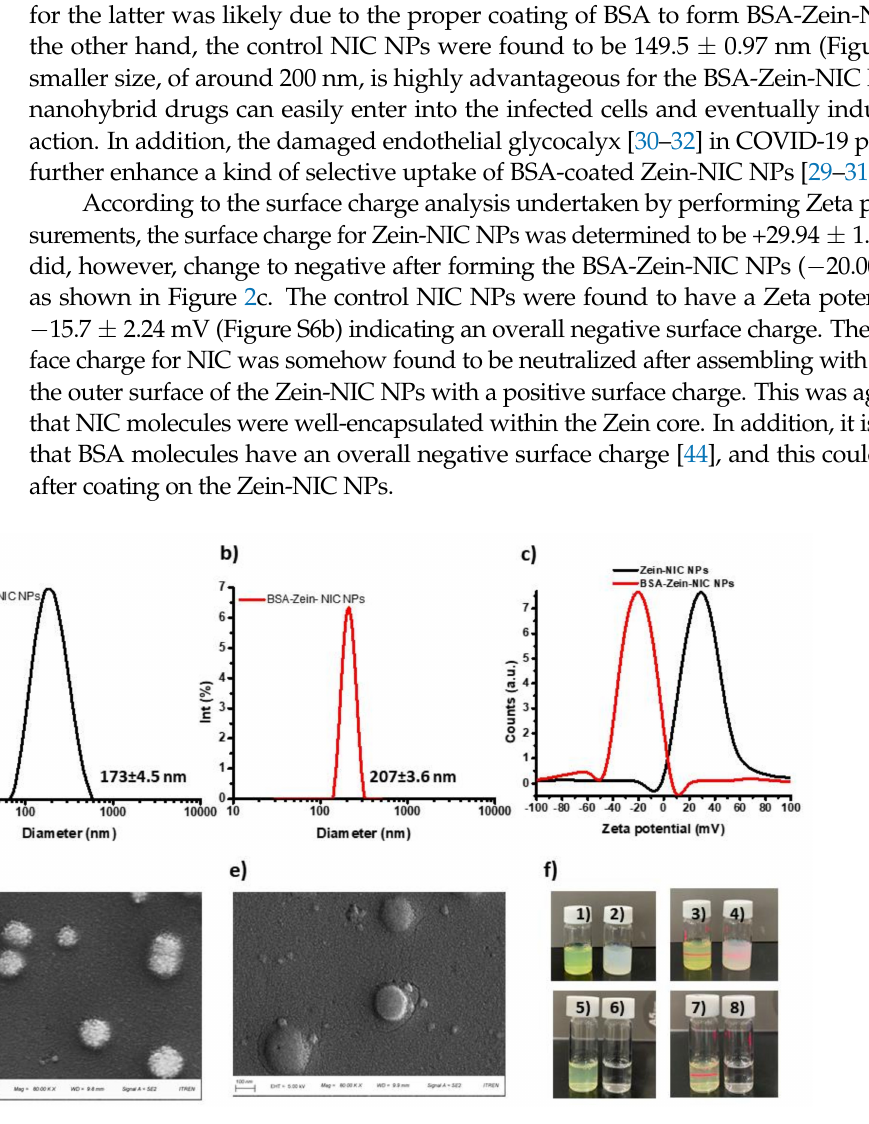
Figure 2. Particle size analysis by DLS and FE-SEM: ( a ) Zein-NIC NPs; ( b ) BSA-Zein-NIC NPs; ( c ) Zeta potential for Zein-NIC NPs and BSA-Zein-NIC NPs in water. FESEM analysis: ( d ) Zein-NIC NPs; ( e ) BSA-Zein-NIC NPs; ( f ) colloidal stability observed for Zein-NIC NPs (2,4,6, and 8) and BSA-Zein-NIC NPs (1,3,5, and 7) before the freeze-drying process (1–4) and after dissolving freeze-dried powder samples in water (5–8). The laser exposure indicated the Tyndall effects shown by stable